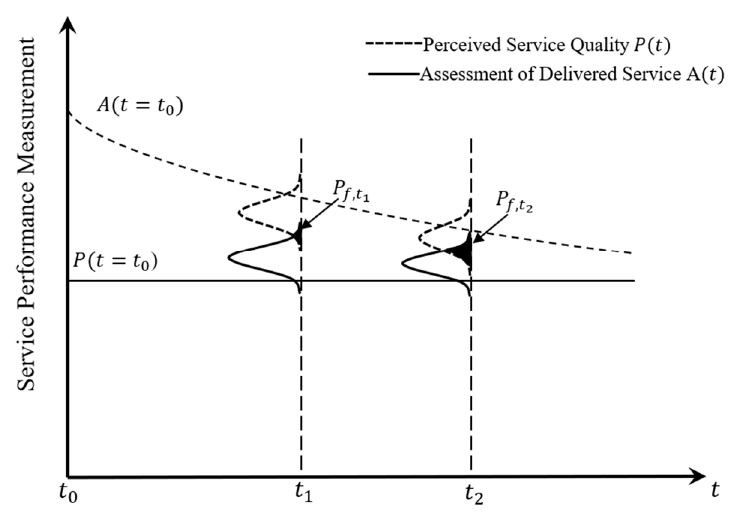
Figure 4. Time-based performance curve for social PPPs.